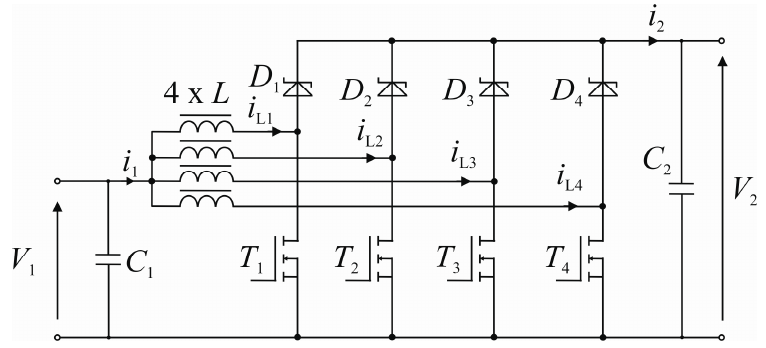
Figure 1. Scheme of the four-leg interleaved boost converter.